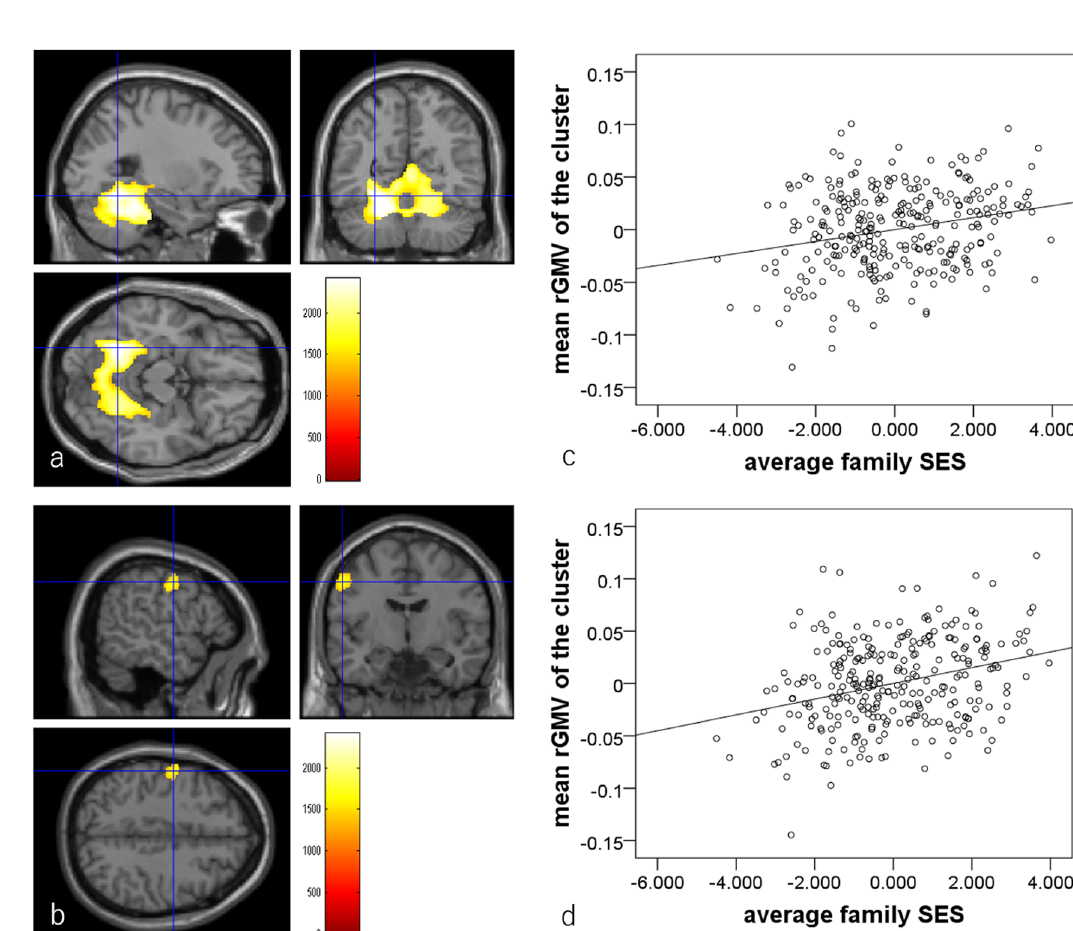
Fig. 3 Associations between greater higher childhood SES and rGMV in cross-sectional analyses ( N = 285). The results shown were obtained using a TFCE of P < 0.05 based on 5000 permutations. The results were corrected at the whole brain level. Signi fi cantly associated regions were overlaid on a “ single subject ” T1 image. The color represents the strength of the TFCE value. Positive associations between rGMV and childhood SES. Signi fi cant associations were observed in the anatomical cluster that primarily spread across the bilateral cerebellum, fusiform gyrus, lingual gyrus, precuneus, parahippocampal gyrus, and calcarine cortex ( a ) and in the anatomical cluster that primarily spread across the left pre- and post-central gyrus ( b ). c , d Partial residual plots with trend lines depicting associations between residuals in the multiple regression analyses. The mean rGMV from the signi fi cant clusters shown in ( a ) and ( b ) respectively were used as the dependent variables and childhood SES was the independent variable.